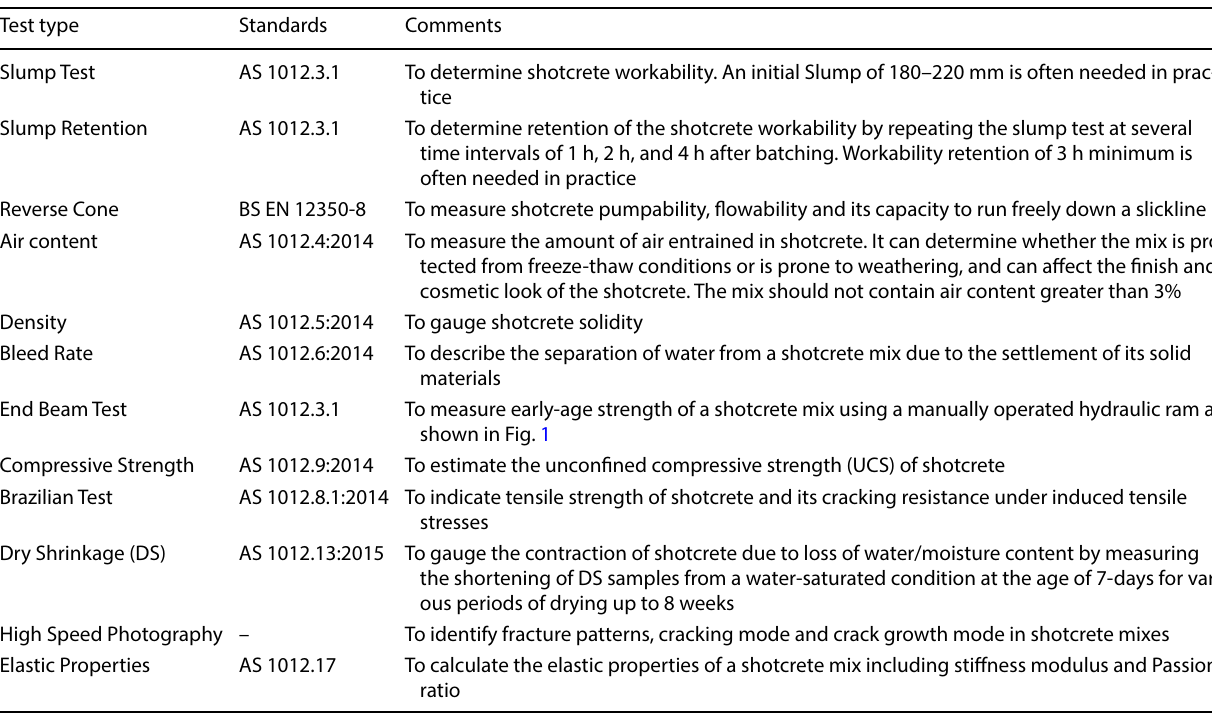
Table 4 List of the tests conducted and their corresponding standards Test